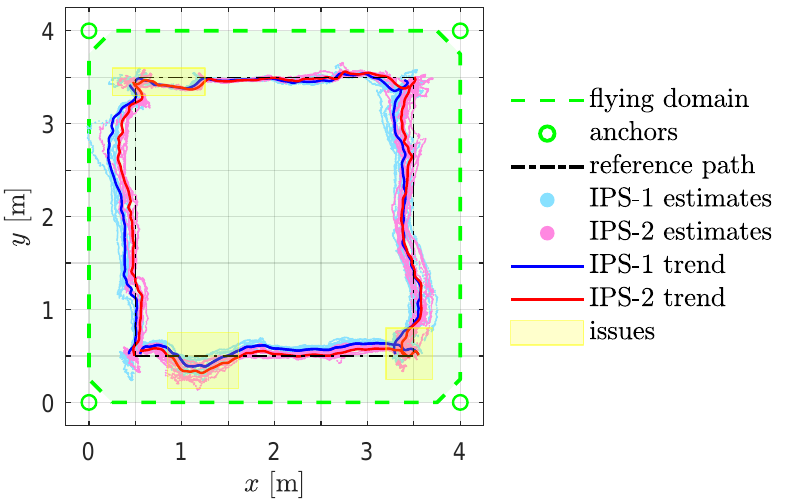
Figure 18. Square-path experiment results, with flying domain delimited by four anchors. The vehicle starts moving from ( 0.5,0.5 ) following the positive x -axis direction. IPS-1 uses EKF only, while IPS-2 uses EKF + DF. Problematic regions of the path are highlighted in yellow. The overall experiment shows a clear improvement when incorporating the proposed DF. Table 2. Square-path experiment results. The RMSEs of an IPS with and another without DF (IPS-2 and IPS-1, respectively) are compared to show the accuracy improvement. The ‘raw’ heading refers to full data stream and the ‘sel.’ heading refers to the undamaged data stream (i.e., no misbehaviour). Average improvement with DF is shown by ∆ . RMSE IPS-2